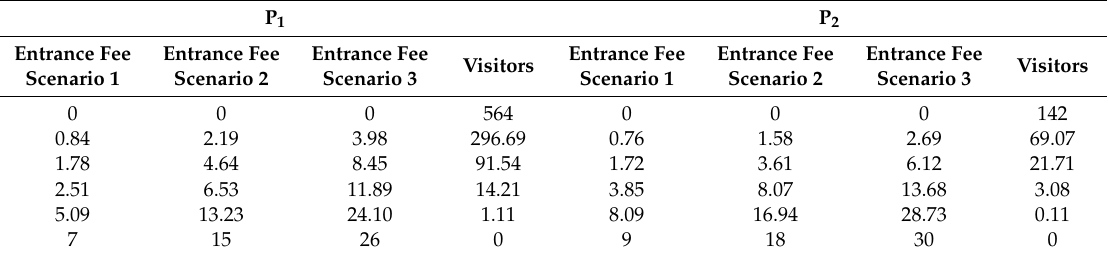
Table 9. Transformed demand function points for the HNP (P 1 and P 2 ).